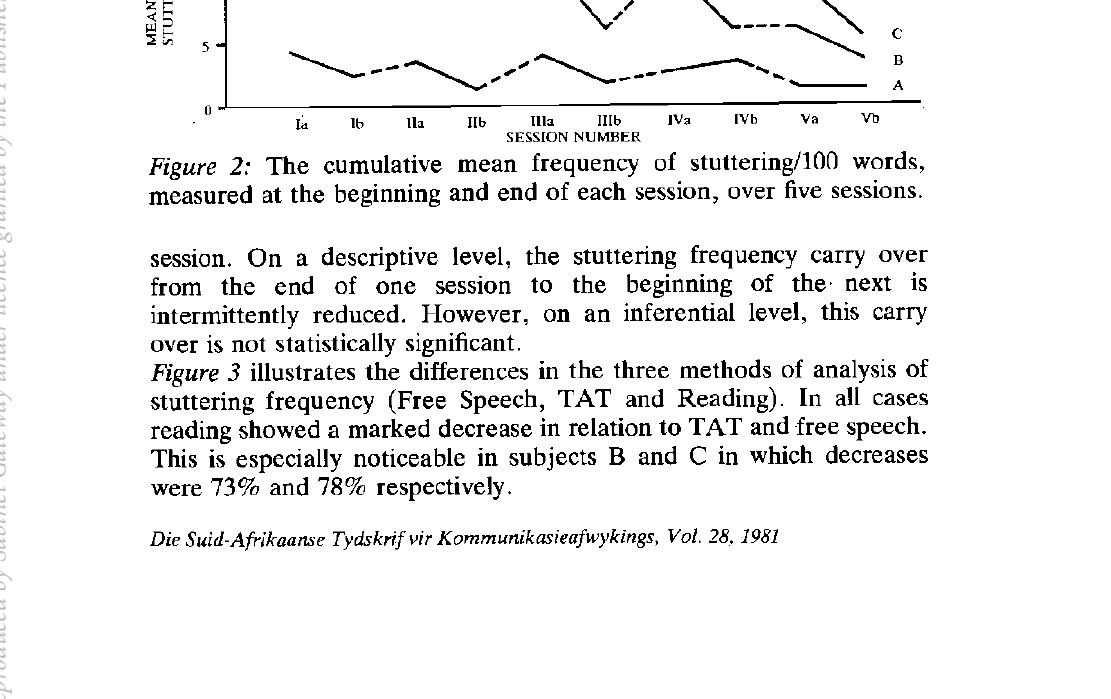
Figure 1: The mean combined reading, TAT, and free speech stuttering frequencies before and after biofeedback.